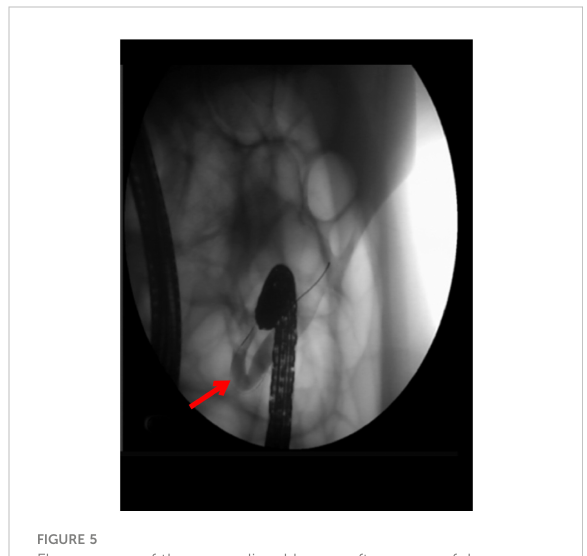
FIGURE 5 Fluoroscopy of the appendiceal lumen after successful cannulation showing the irregularly dilated appendiceal lumen with a diameter of 1.0cm and multiple fi lling